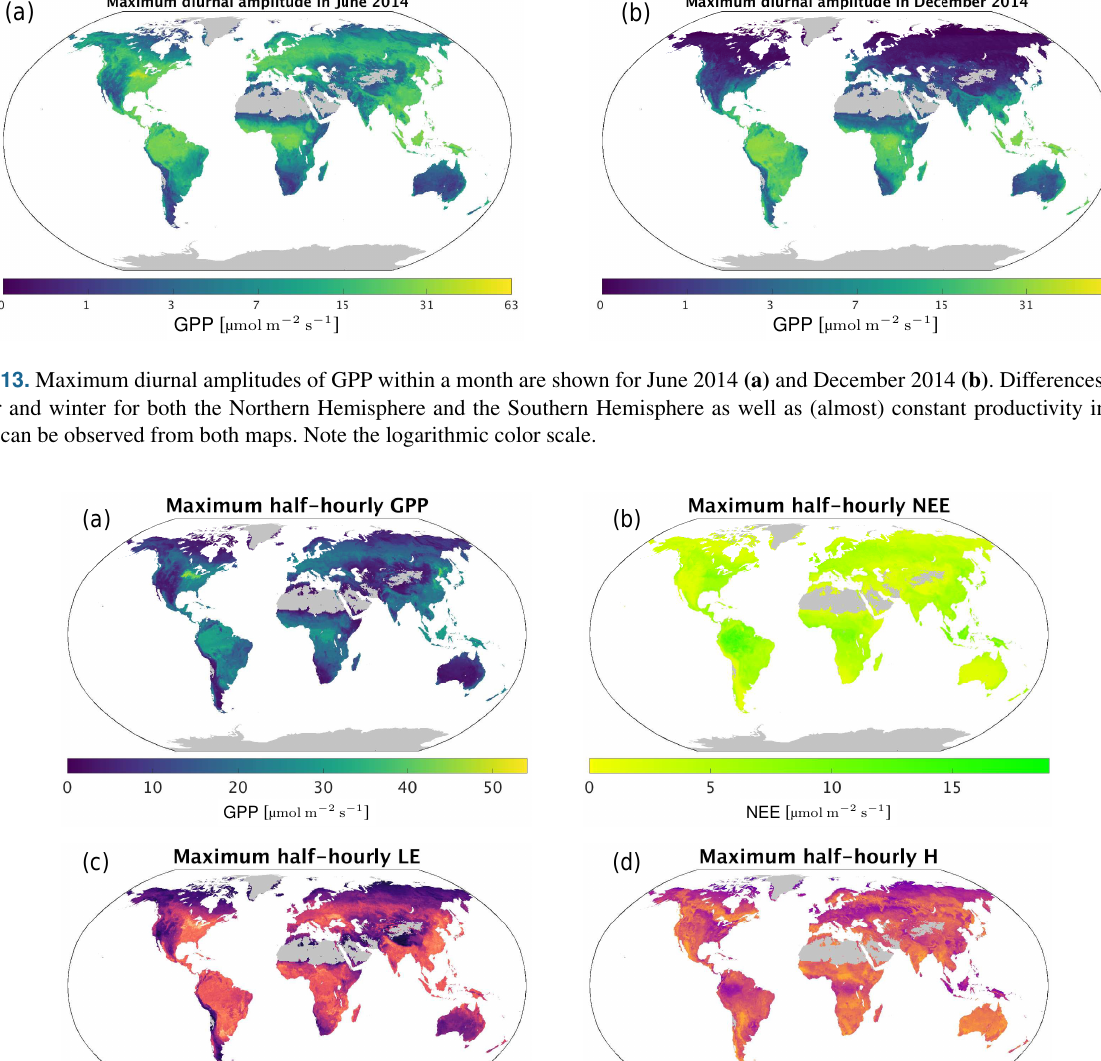
a monthly resolution and have computed the mean seasonal cycle (MSC) from the years 2001 to 2010 for each grid